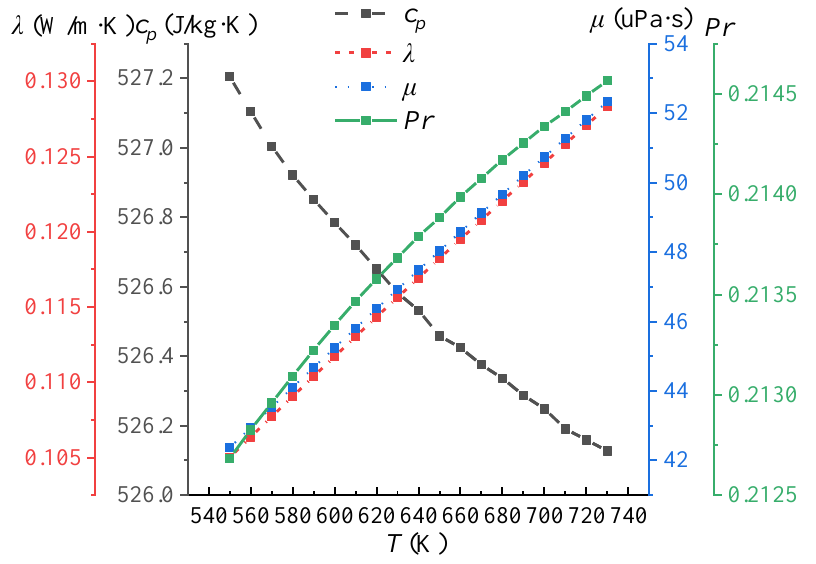
Figure 3. The properties of He–Xe ( P = 0.65 Mpa, M mix = 40 g/mol). The convergence standard of the continuity and momentum equation is set as 10 −5 .